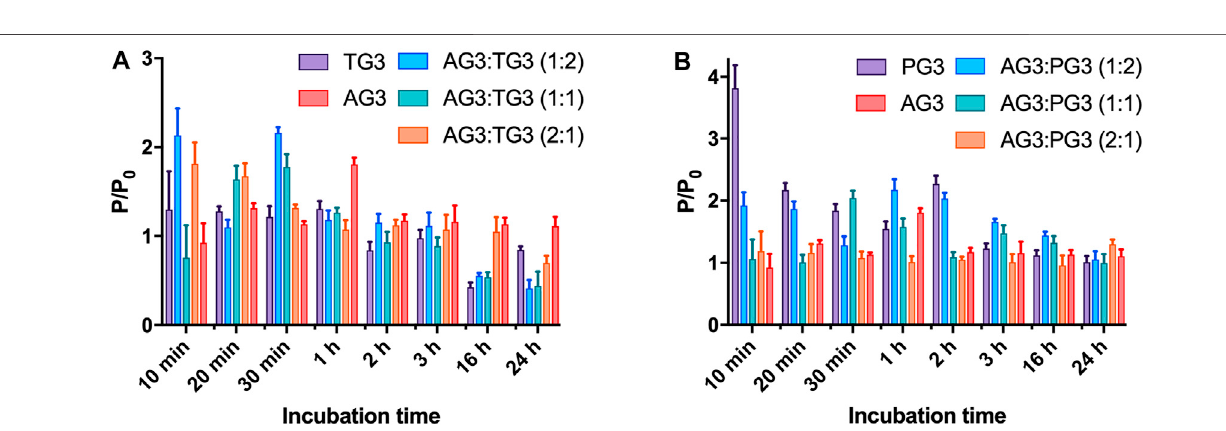
Frontiers in Chemistry |